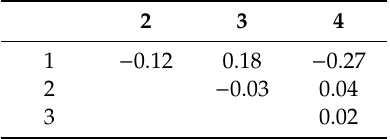
Table 3. Component